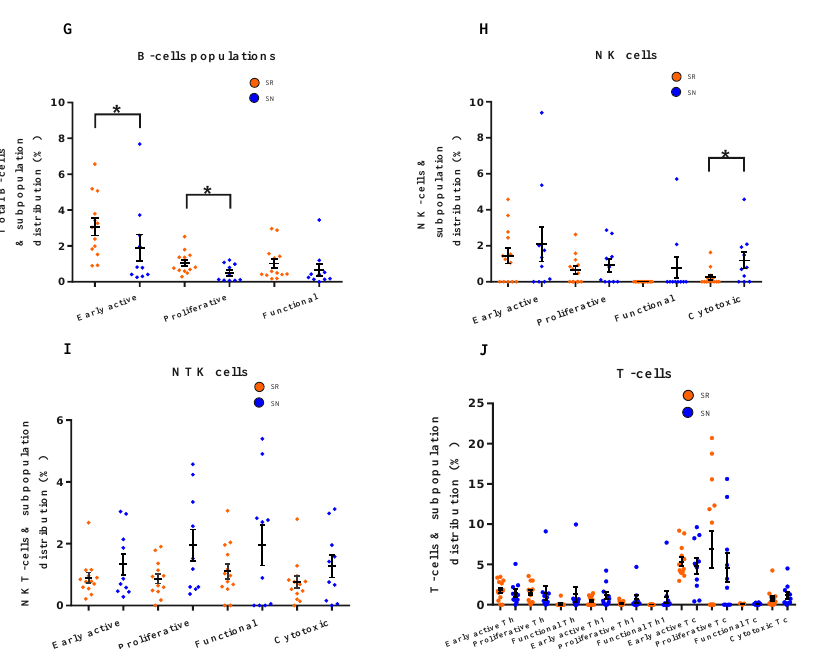
Figure 4. The humoral and cell-mediated immune responses of SNs compared the age- and sex- matched SRs after two doses of vaccines. The flow cytometry analysis elicits both humoral and cell-mediated responses by enumeration of lymphocyte cellular markers and proliferation assays. ( A – F ) After two doses of vaccines, responders showed significantly higher B-cells than sero-naïve par- ticipants in their PBMCs. In contrast, SNs had higher NK cells and NKT cells than SRs, but no sta- tistical significance was reached. ( G – J ) SRs showed significantly higher numbers in early active and proliferative B-cells than SNs. In contrast, SNs had significantly higher cytotoxic NK cells. Abbrevi-